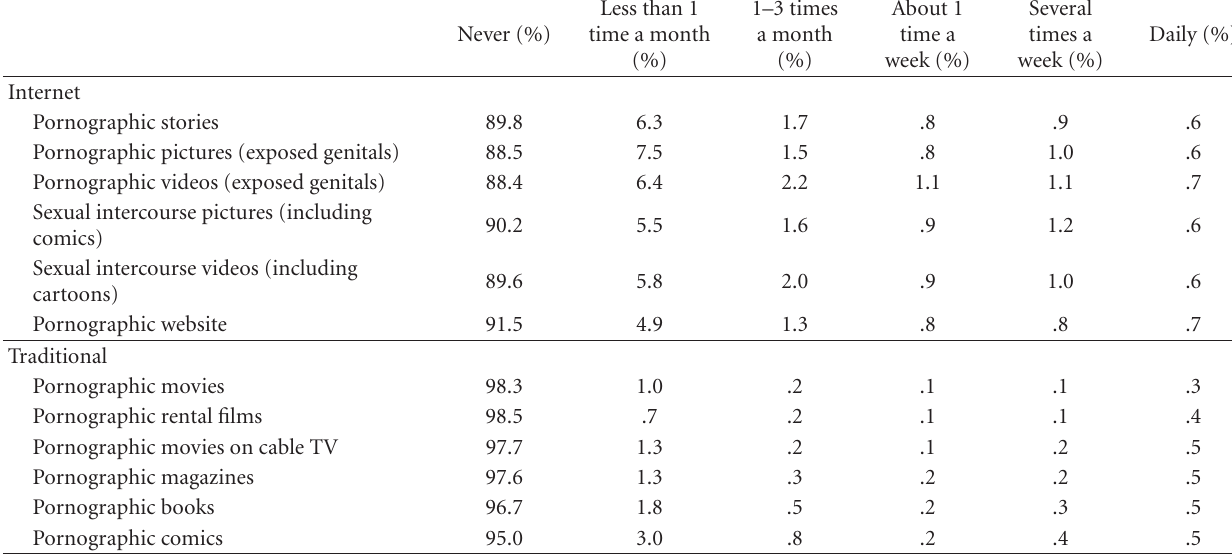
Table 2: Past year exposure to internet and traditional pornographic